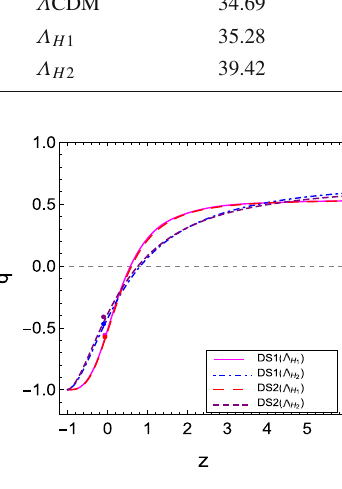
Fig. 5 The redshift evolution of the deceleration parameter for Λ H 1 and Λ H 2 models obtained from observational data sets DS1 and DS2. A dot denotes the current value of q (hence q 0 )